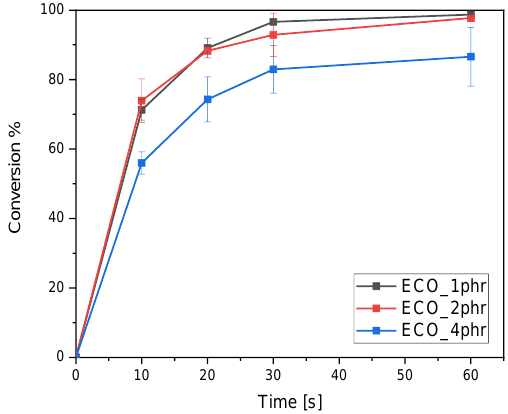
Figure 1. Conversion of epoxy group (from ATR FT-IR) for ECO as a function of time at varying concentration of the photo-initiator. THS photo-initiator was added in 1, 2, and 4 phr. The light intensity was set as 130 W/cm 2 .